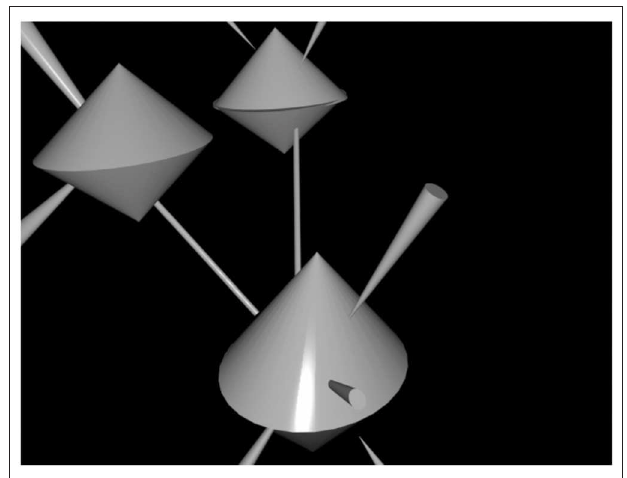
FIGURE 2 | Exchange diagram involving multiple